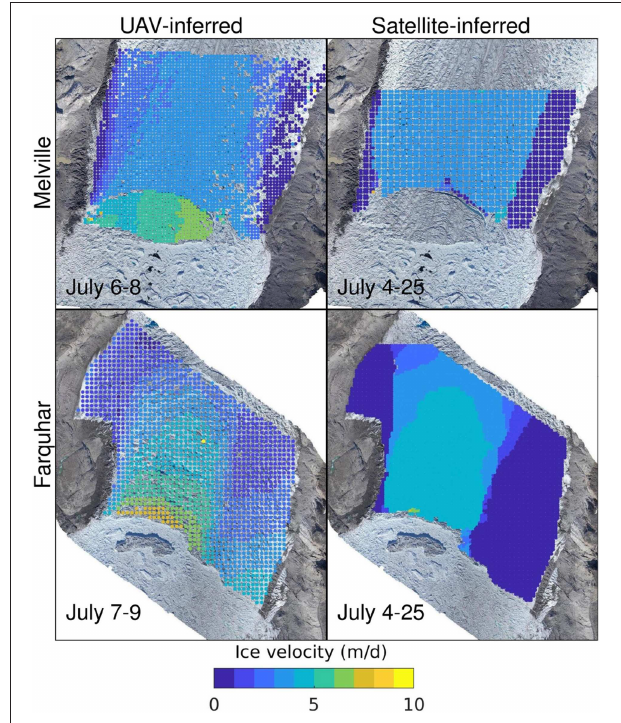
FIGURE 5 | Horizontal ice speed inferred by UAV (2 days separation, left panels) and satellite images (21 days separation, right panels) in July 2017 at Melville (top panels) and Farquhar (bottom panels) glaciers. The velocity directions (not shown) are aligned with the